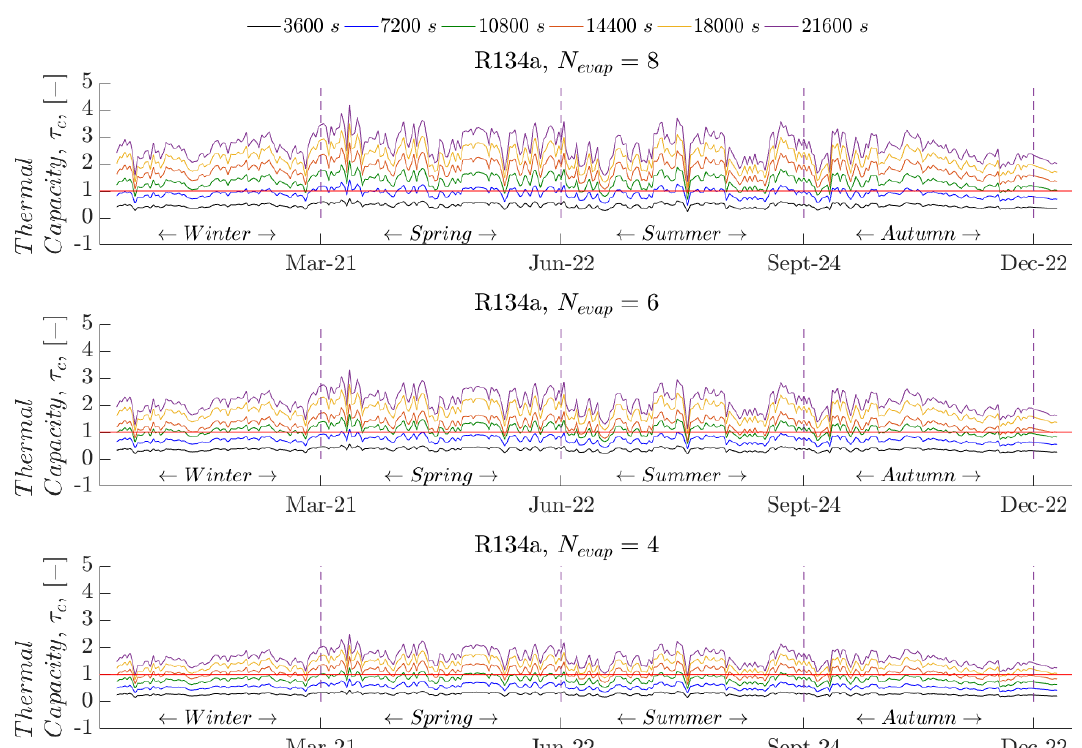
Figure 4 . Thermal capacity of the heat pump during the year using R404A as working fluid.